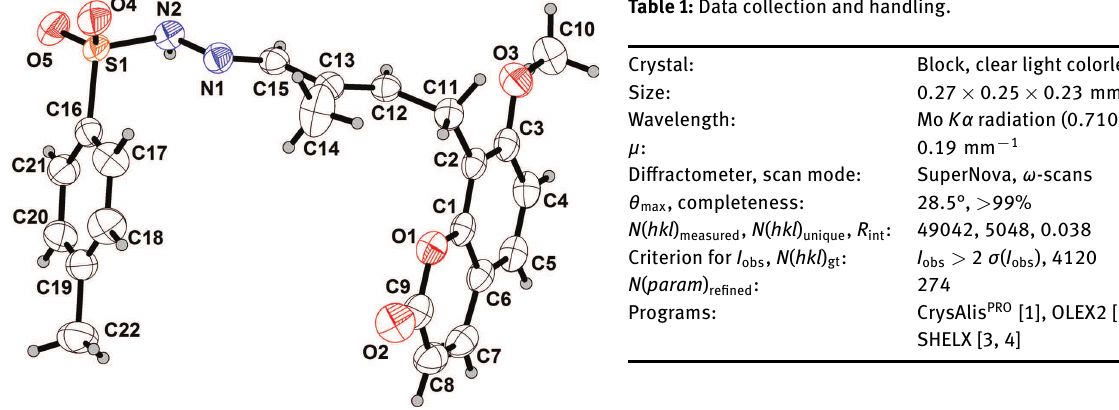
Table 1: Data collection and handling.